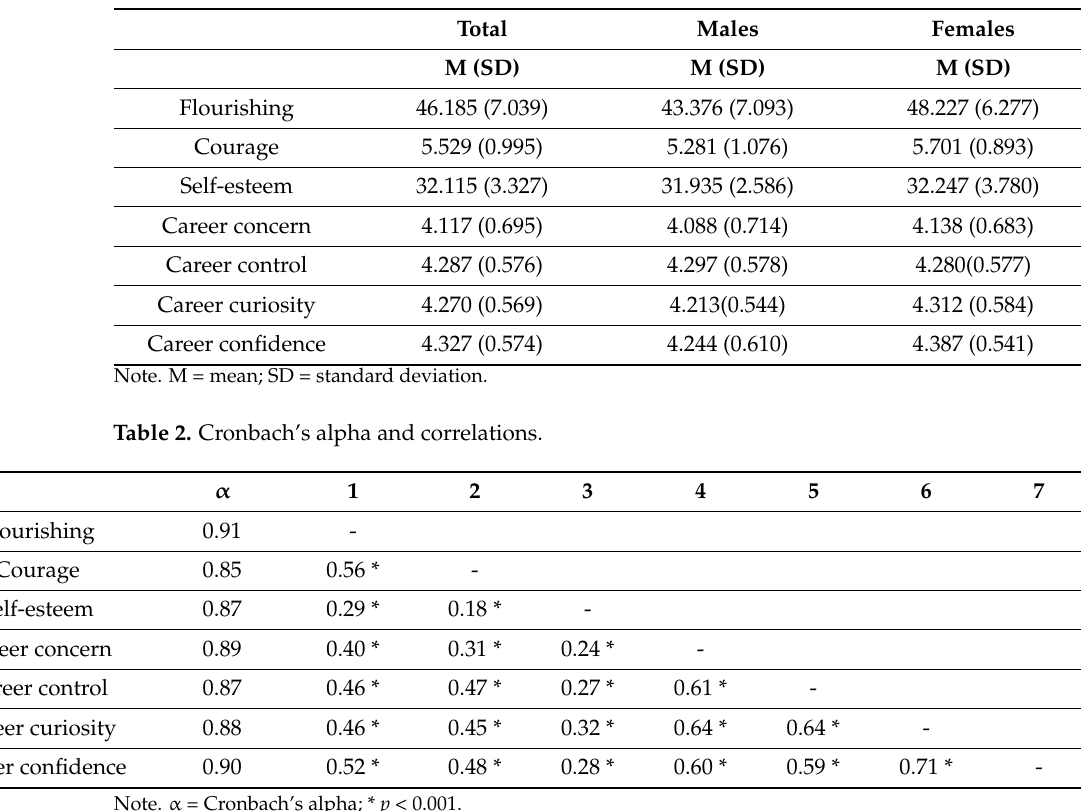
Table 1. Means and standard deviations for the total sample, females, and males.